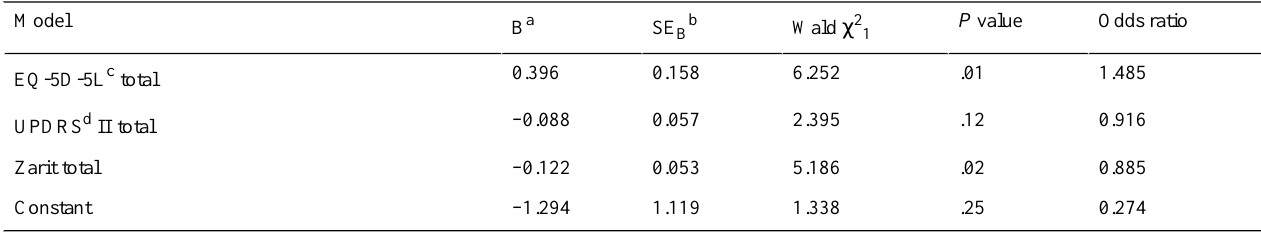
Table 5. Summary of binary logistic